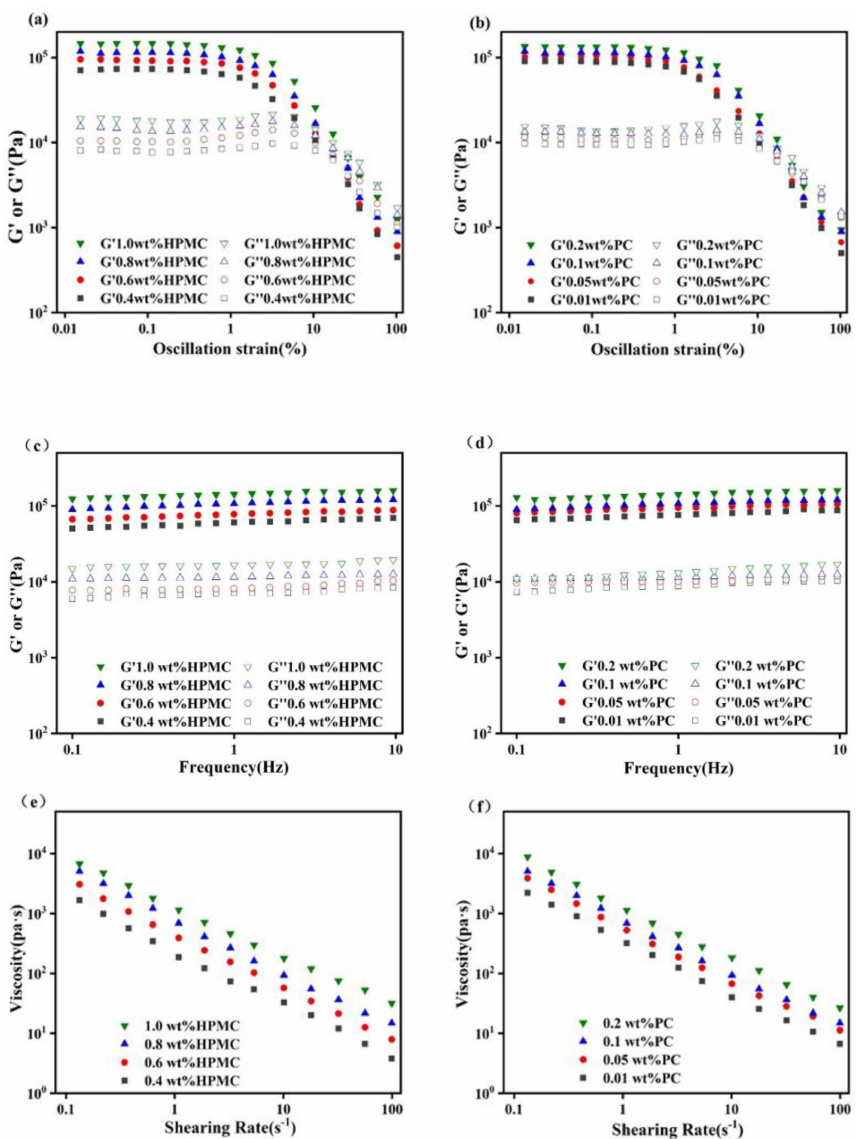
Figure 5. Amplitude sweeps ( a ), frequency sweeps ( c ) and flow measurement ( e ) for oleogels prepared by different HPMC concentrations (0.4, 0.6, 0.8 and 1.0 wt%) and a constant PC concentration (0.1 wt%). Amplitude sweeps ( b ), frequency sweeps ( d ) and flow measurement ( f ) for oleogels prepared by different PC concentrations (0.01, 0.05, 0.1 and 0.2 wt%) and a constant HPMC (0.8